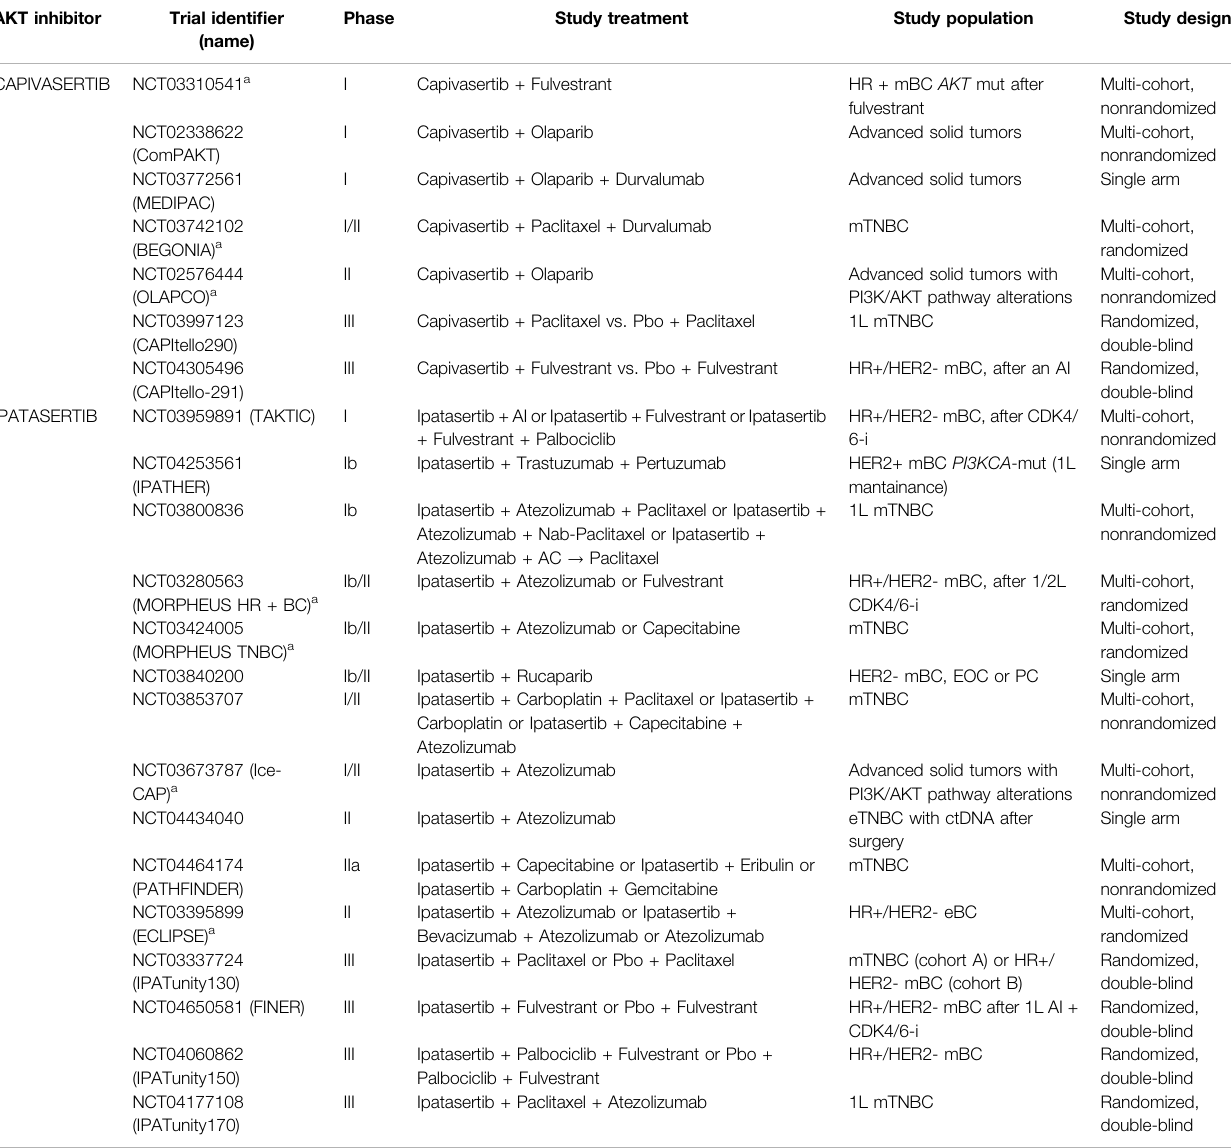
TABLE 3 | Ongoing trials of AKT inhibitors in breast cancer. AKT